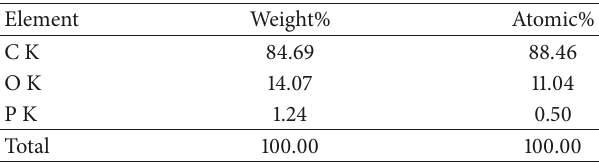
Table 9: Elemental composition of 𝐵 2